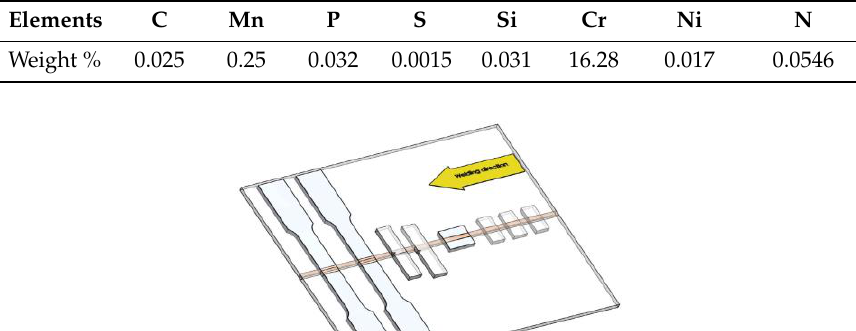
Table 1. Chemical composition of 430 ferritic stainless steel.